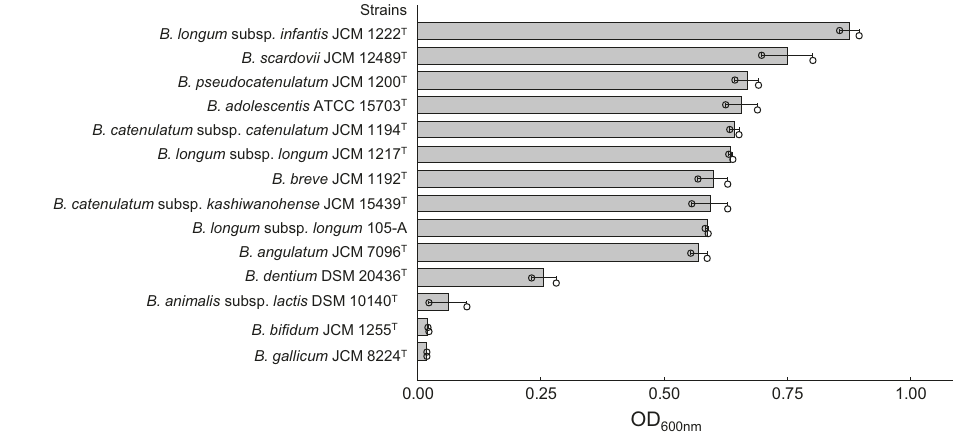
Fig. 3 Growth capability of 14 strains belonging to 13 different Bi fi dobacterium species/subspecies in modi fi ed MRS medium supplemented with lactulose as the sole carbon source. Strains with an OD 600nm value greater than 0.3 after 24 h incubation was classi fi ed as a lactulose-assimilating phenotype (see Fig. 2b). The presented data are the mean ± SD of at least two independent assays.